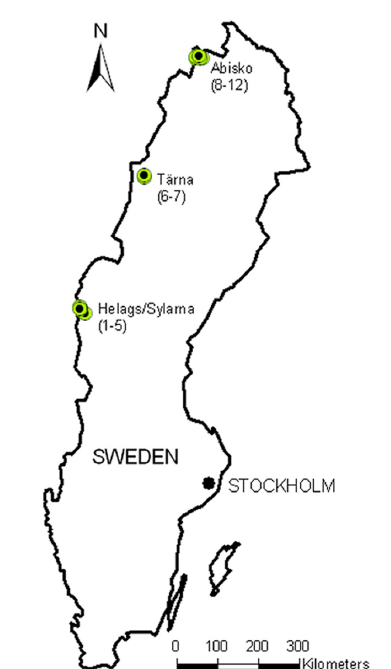
Figure 2: Location map showing the three main study areas along the Swedish Scandes.